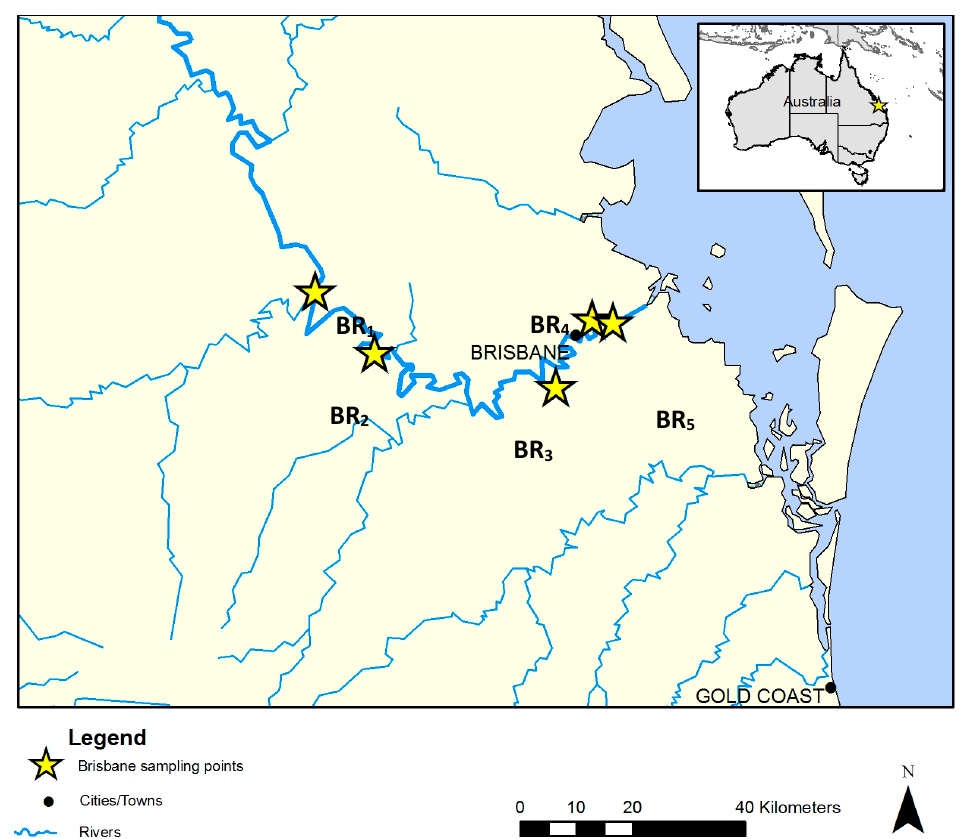
Figure 1. Map of the Brisbane River (BR) and the selected sampling sites (BR 1 –BR 5 ).